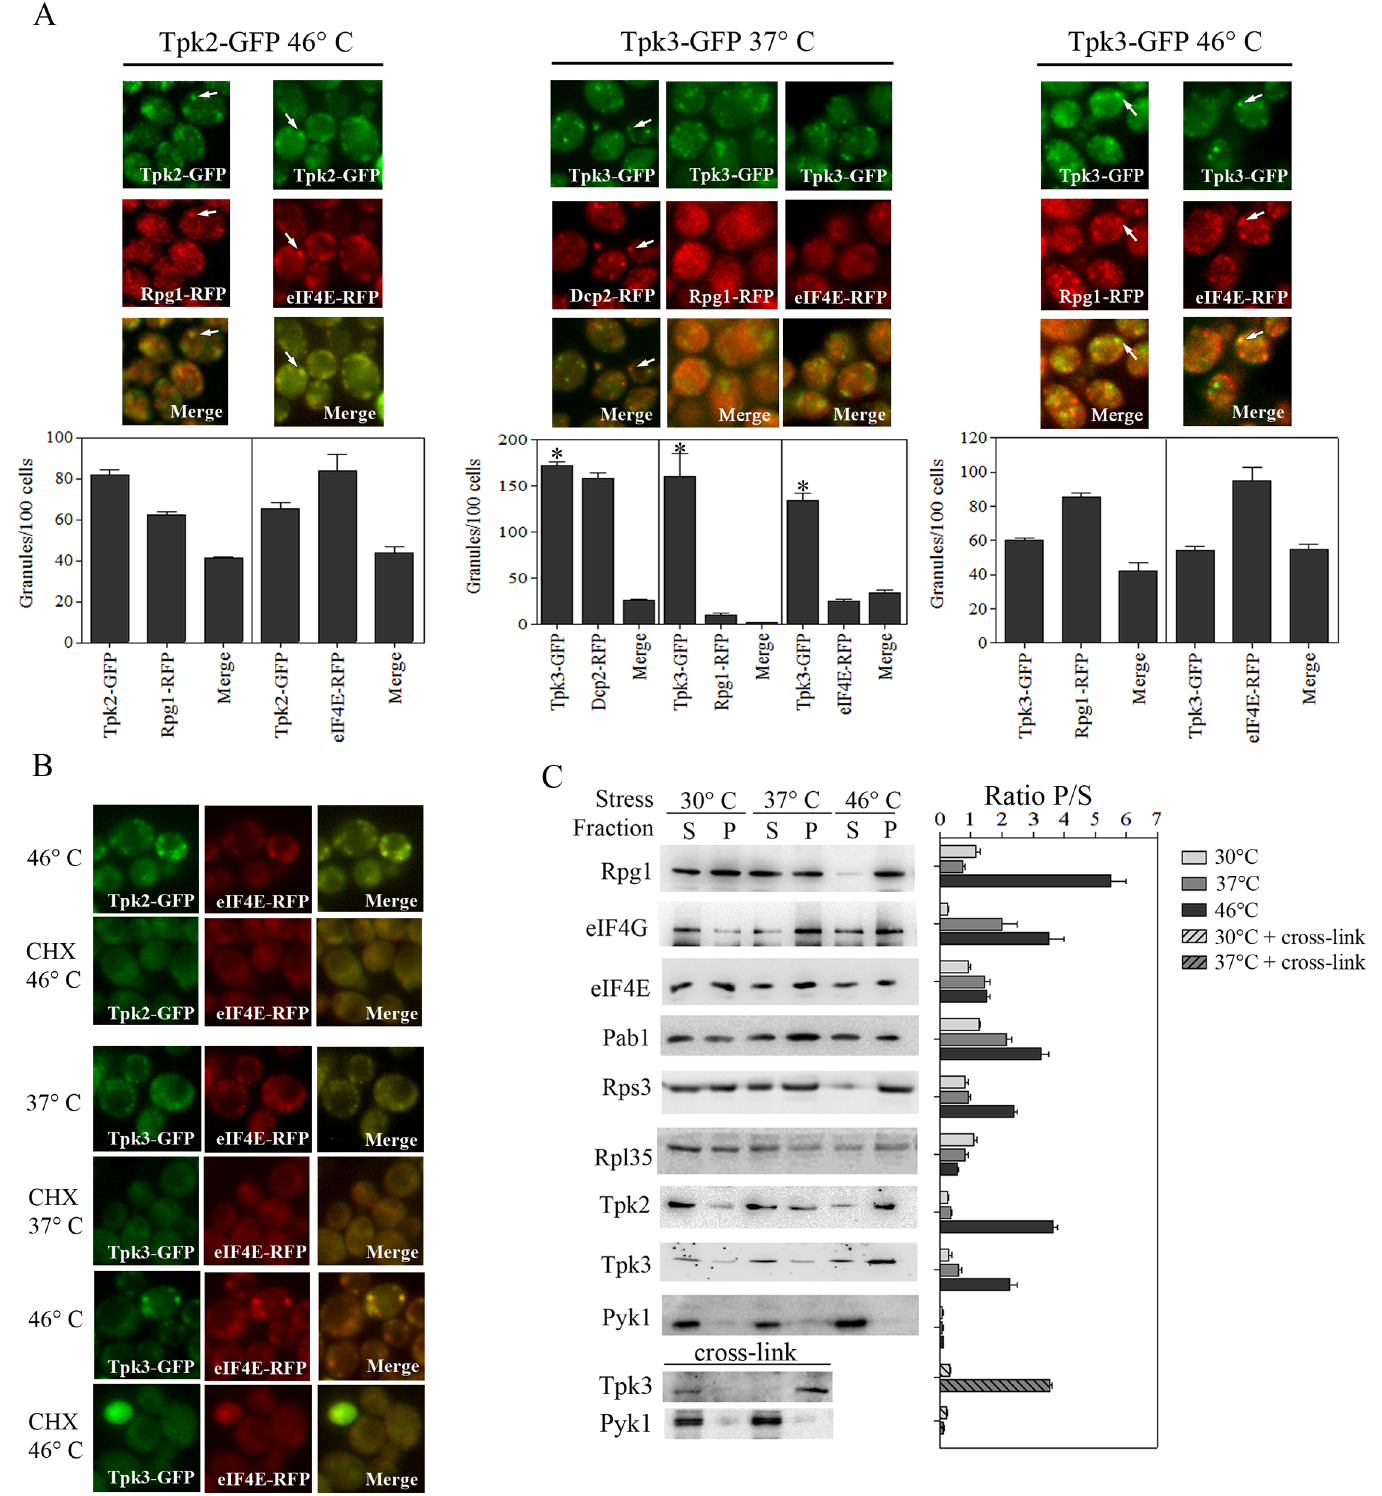
Fig 2. Characterization of Tpk2 and Tpk3 granules evoked during mild and severethermal stress. (A) Cells co-expressing Tpk2-GFP or Tpk3-GFP and Rpg1-RFP or eIF4E-RFP and Tpk3-GFP and Dcp2-RFP were grown to exponential phase (30˚C) and then incubatedat 46˚C for 10 minutes or 37˚C for 30 minutes. Co-localization was determined by confocalmicroscopy. Arrows indicateTpk-GFP granularlocalization and merge. Lower graphs show the